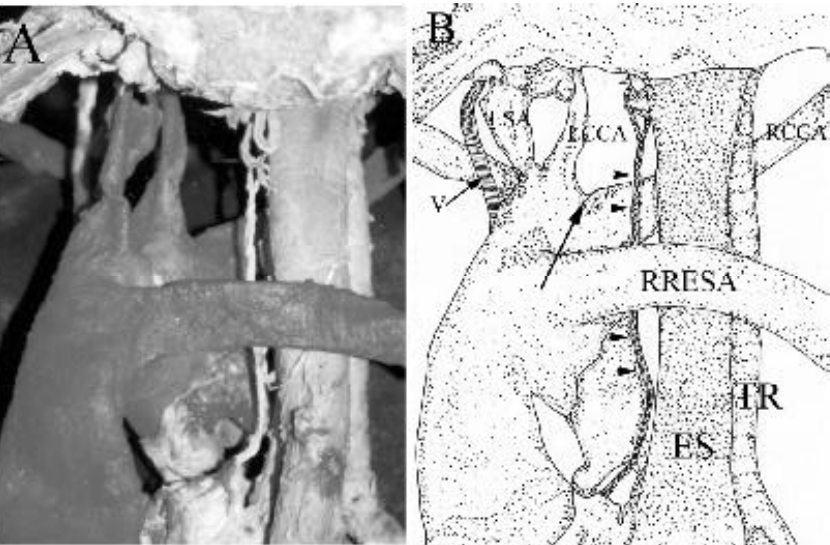
FIGURE 1 - Photograph (A) and schematic drawing (B) of the posterior view of the dissected right retroesophageal subclavian artery (RRESA). Note that the common carotid arteries have a common origin in a bicarotid trunk (arrow). The left subclavian artery (LSA) has a normal origin while the RRESA originates distal and posterior from the aortic arch. V indicates the left vagus nerve and the arrowheads indicate the left recurrent laryngeal nerve. RCCA = right common carotid artery, LCCA = left common carotid artery, ES = esophagus and TR = trachea.